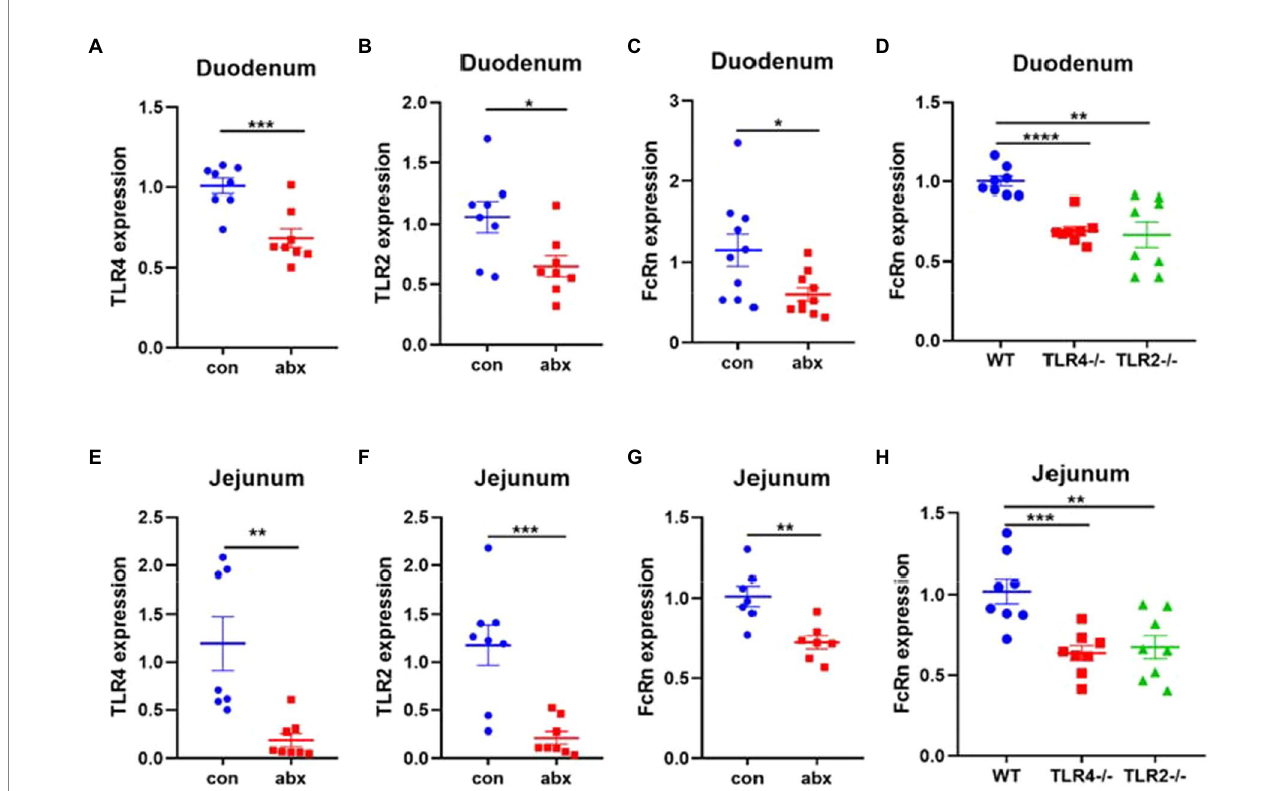
FIGURE 6 Antibiotic treatment affects the absorption of maternal antibodies IgG in pups. (A–C) TLR4, TLR2 and FcRn mRNA expression in duodenum of pups (3-day old). (D) FcRn mRNA expression in the duodenum of pups wild type and TLR4 and TLR2 knockout mice. (E–G) TLR4, TLR2 and FcRn mRNA expression in jejunum of pups. (H) FcRn mRNA expression in the jejunum of pups wild type and TLR4 and TLR2 knockout